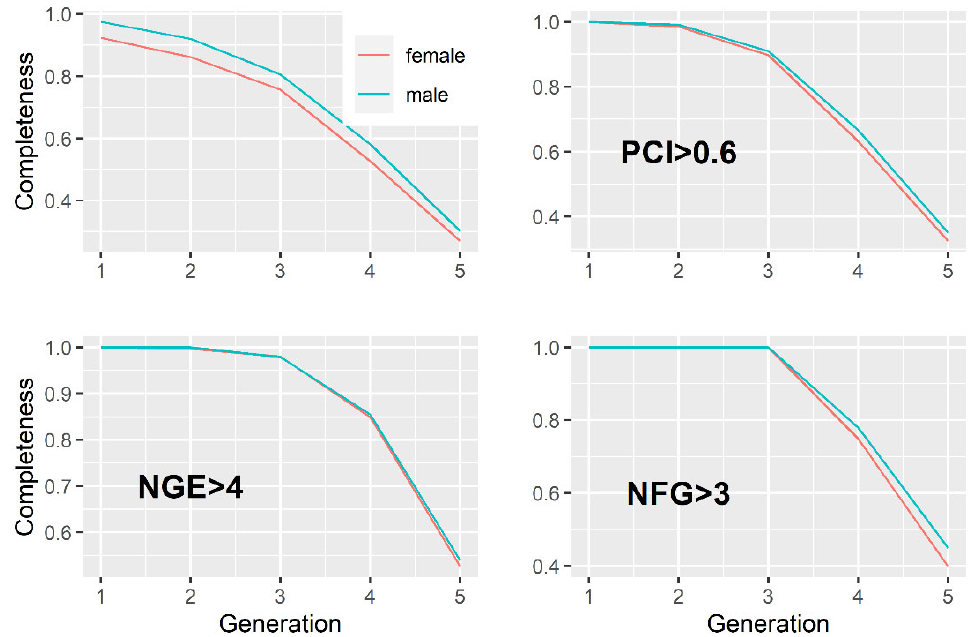
Figure 3. Completeness of the pedigree of the reference population.